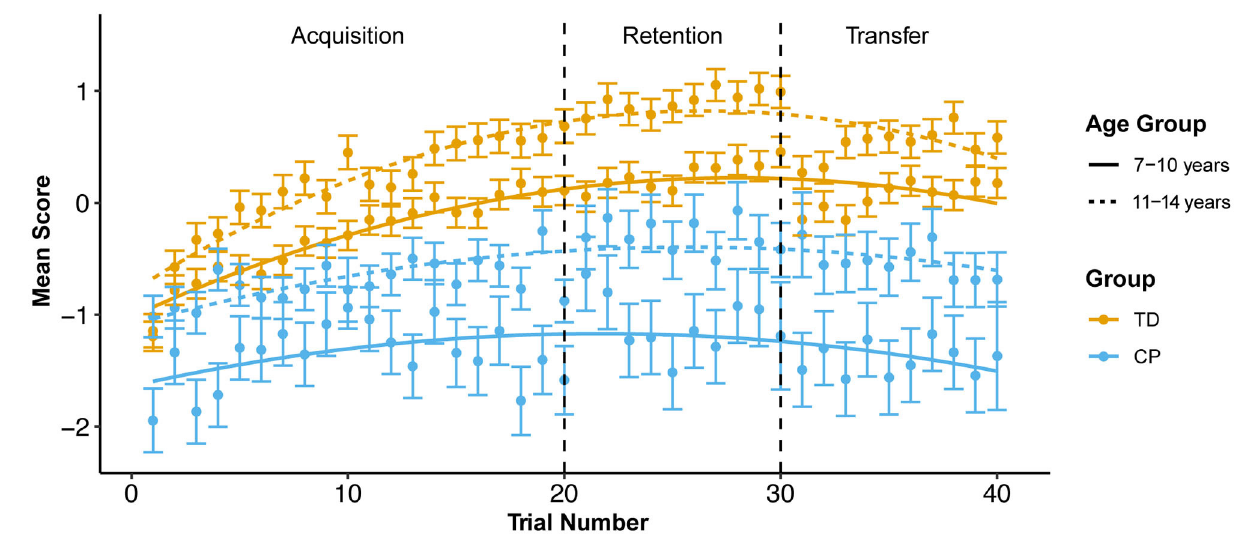
FIGURE 3 | Mean z-score by group and age group across all trials at each session. Error bars use sdDiff (the standard deviation of the pair-wise trial-to-trial differences). SE is calculated by devising the SD by the square root of the number of subjects in each trial.